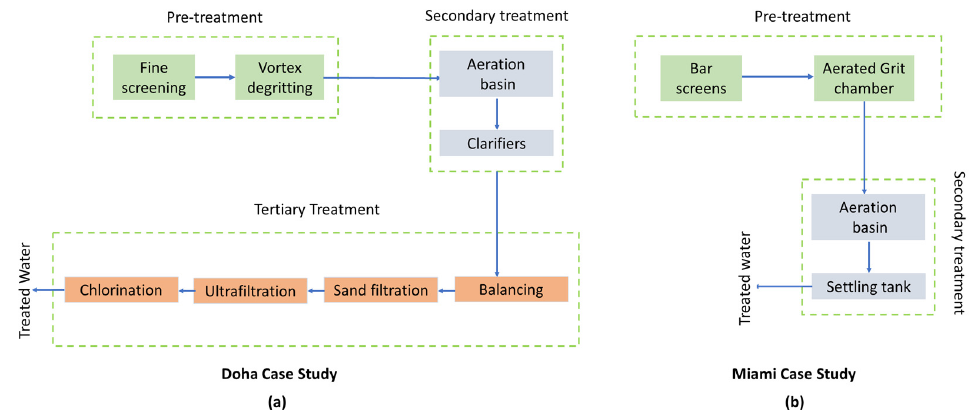
Figure 5. Wastewater treatment processes in Doha and Miami. ( a ) represents the process flow diagram of the Doha West wastewater treatment plant in Doha, while ( b ) is the representation of Miami-Dade wastewater treatment plant in Miami. In Doha, treatment is to tertiary level whereas in Miami it is to secondary level.